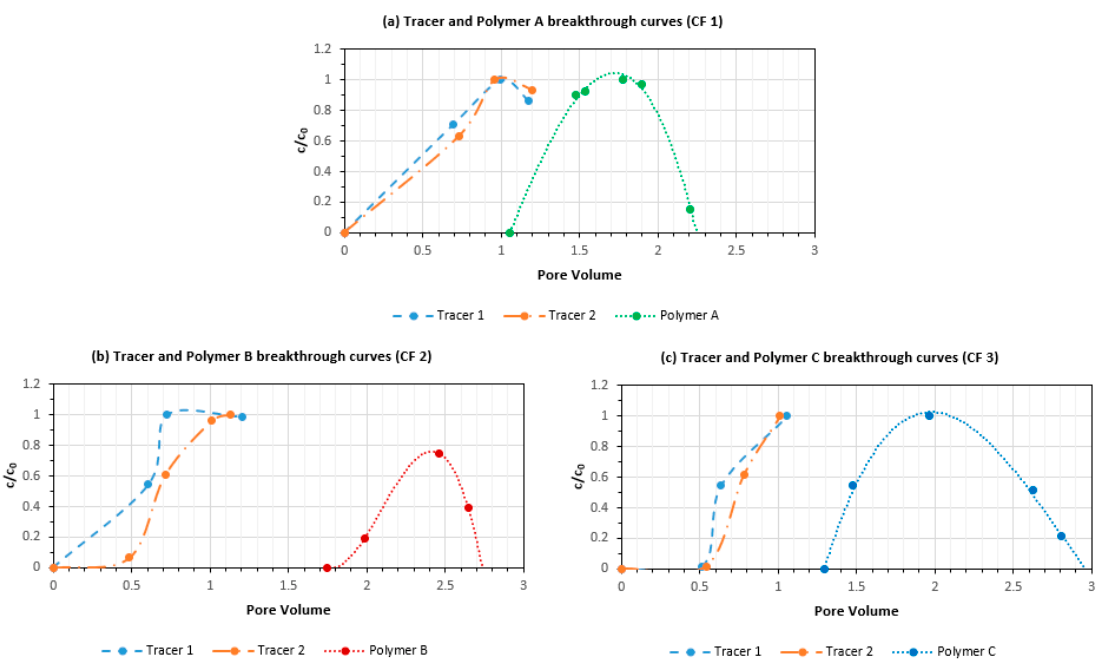
Figure 10. Polymer and tracer breakthrough curves for all experiments ( a ) CF 1; polymer A ( b ) CF 2 polymer B ( c ) CF 3; polymer C.